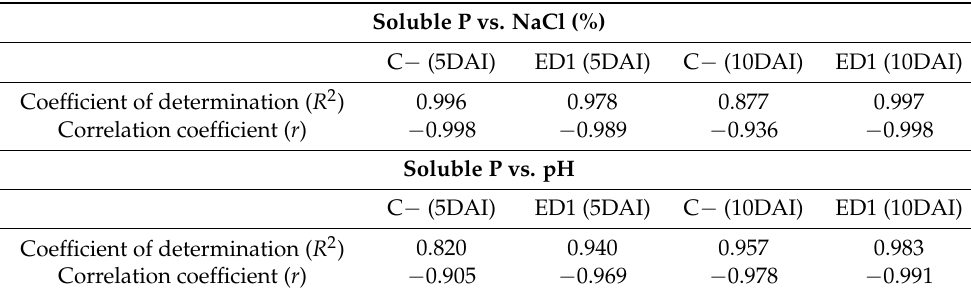
Table 3. Analysis of the variation of soluble P concentrations released by S. rubidaea ED1 and E. coli DH5 α strain as a function of NaCl levels and pH values.